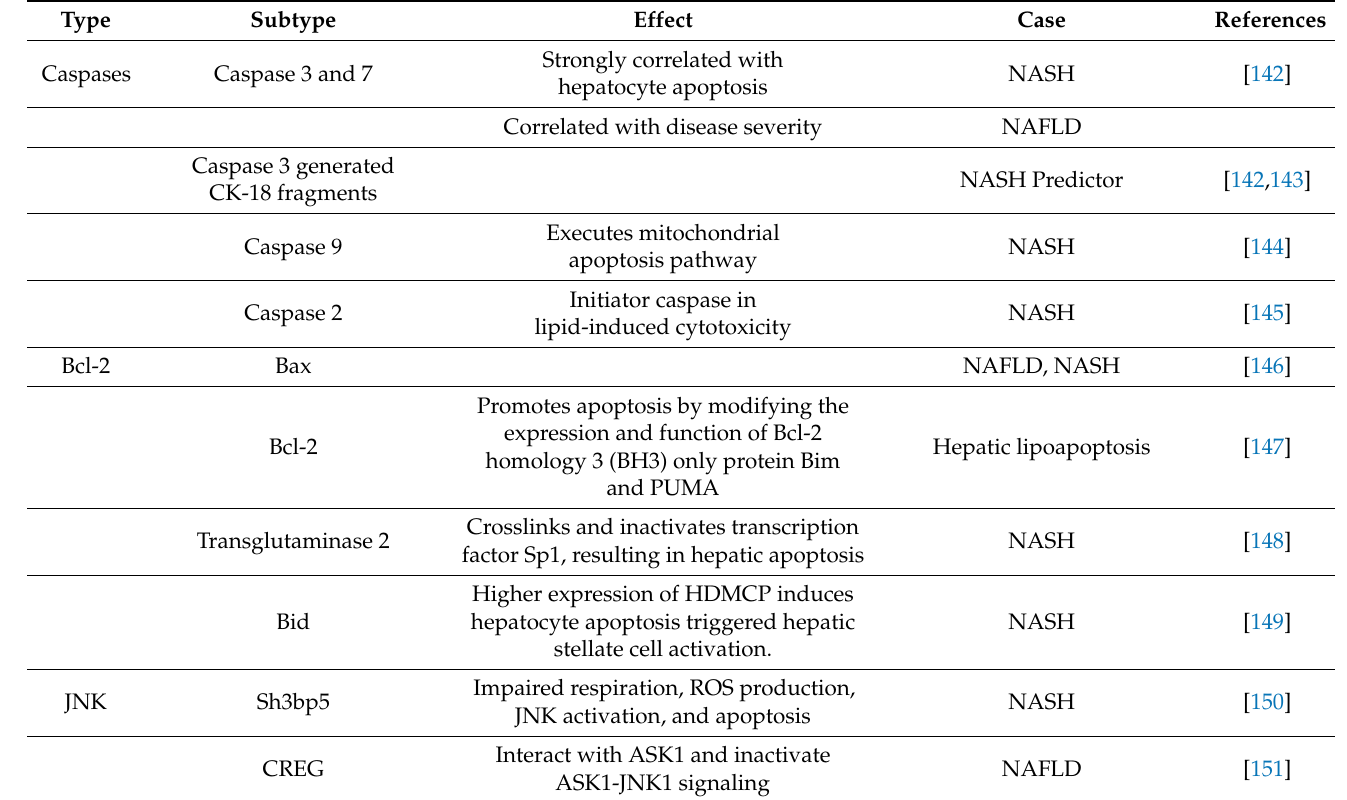
Table 2. Different apoptosis markers involved in nonalcoholic fatty liver disease (NAFLD)/nonalcoholic steatohepatitis